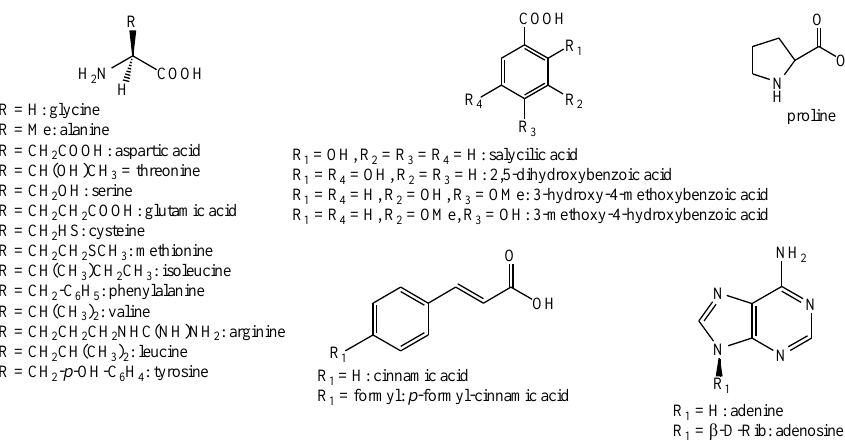
Figure 21. Other compounds identified in Pedicularis species—part 2.